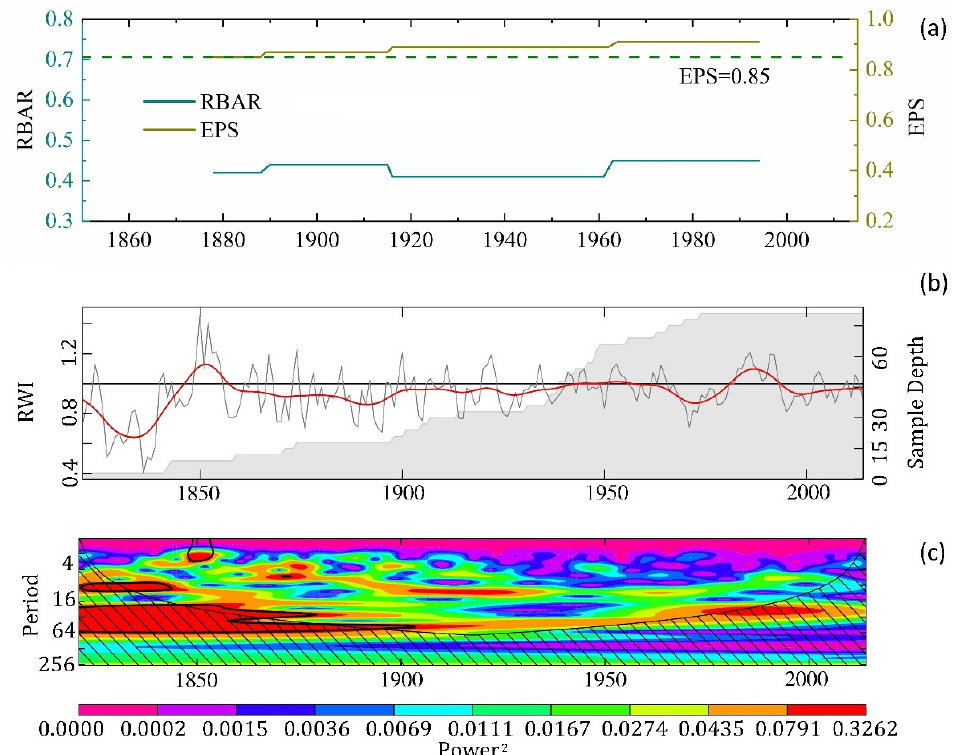
Figure 2. ( a ) Plot of running expressed population signal (EPS) and mean inter-series correlation (Rbar) of tree-ring width (TRW) chronology; ( b ) Tajikistan TRW chronology (standard (STD)) detrended using a 10-year smoothing spline curve (red line) and the sample depths (gray shaded area) with respect to time; ( c ) Wavelet power spectrum. The contour levels were chosen so that 75, 50, 25, and 5% of the wavelet power was above each level. The black contour represents the 1% significance level with a red noise (autoregressive lag1) background spectrum. RWI refers to the ring width index.